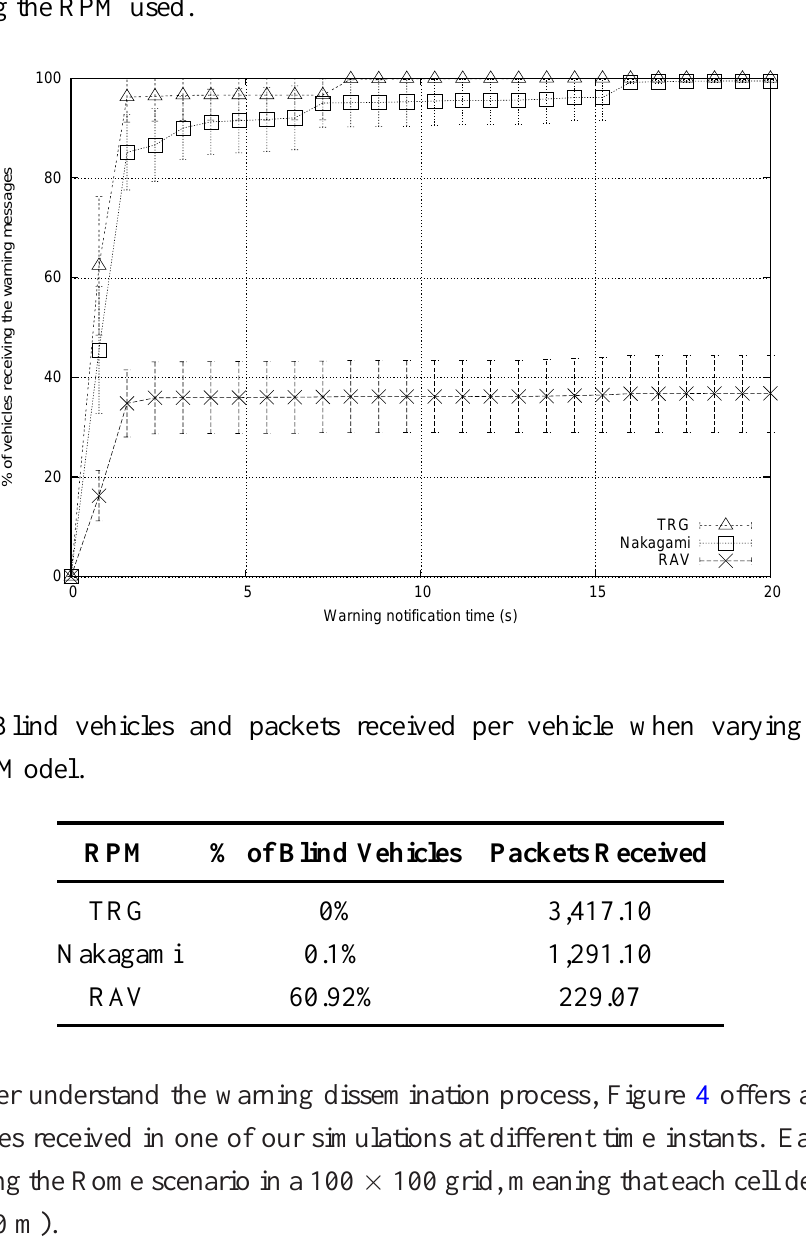
Figure 3. Cumulative histogram for the time evolution of disseminated warning messages when varying the RPM used.